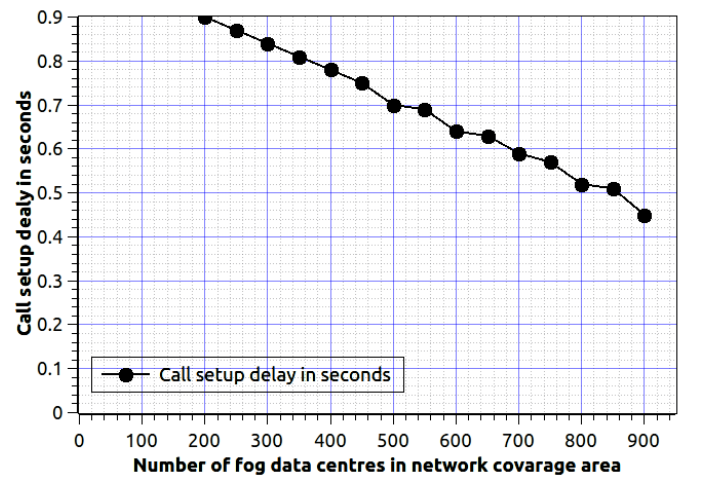
Figure 9. Number of the fog data center in the network service area verses call setup delay.